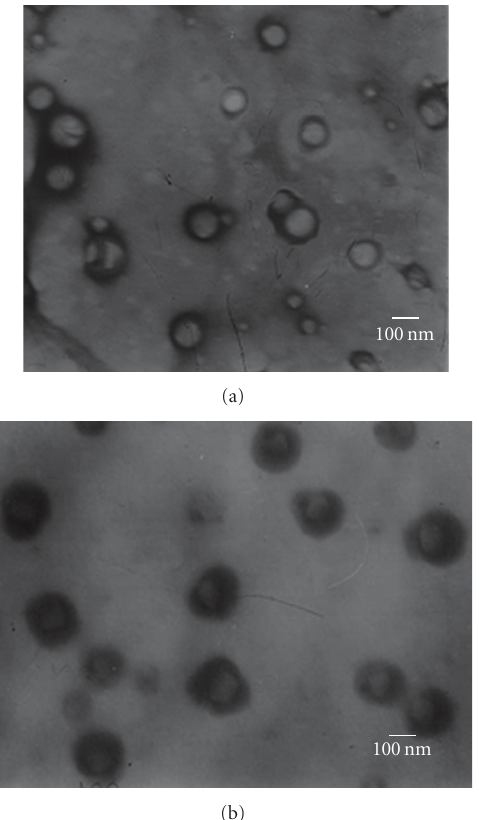
Figure 1: TEM imaging of DNA-NPs (a) and MAN-DNA-NPs (b).